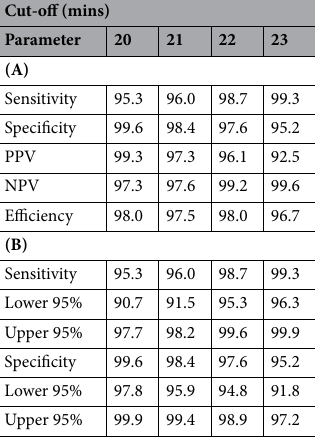
Table 5. Hayat genetics RT-LAMP sensitivity, specificity, positive predictive value (PPV), negative predictive value (NPV) and efficiency (A). Four different TTT cut-off times were used for comparison with RT-PCR results. Sensitivity and specificity with 95% confidence limits (B).